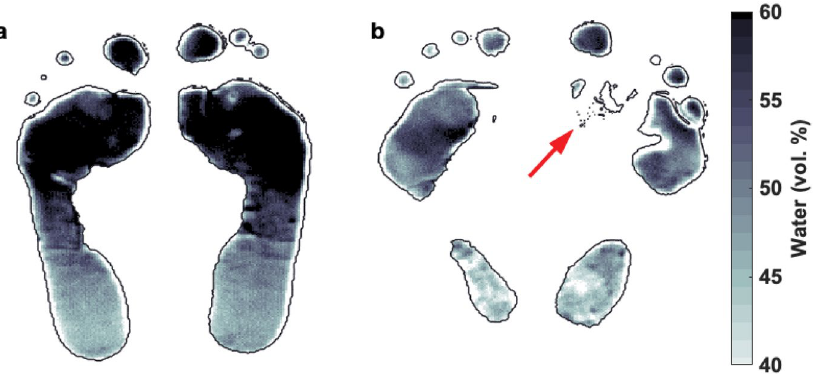
Figure 4. Hydration image of ( a ) a diabetic patient with no complications and ( b ) a diabetic patient with complications. An ulcer, covered by a patch (red arrow), is noticeable on the right metatarsal area of the diabetic patient with complications which, in turn, presents lower hydration along the foot sole compared to the diabetic patient with no complications.